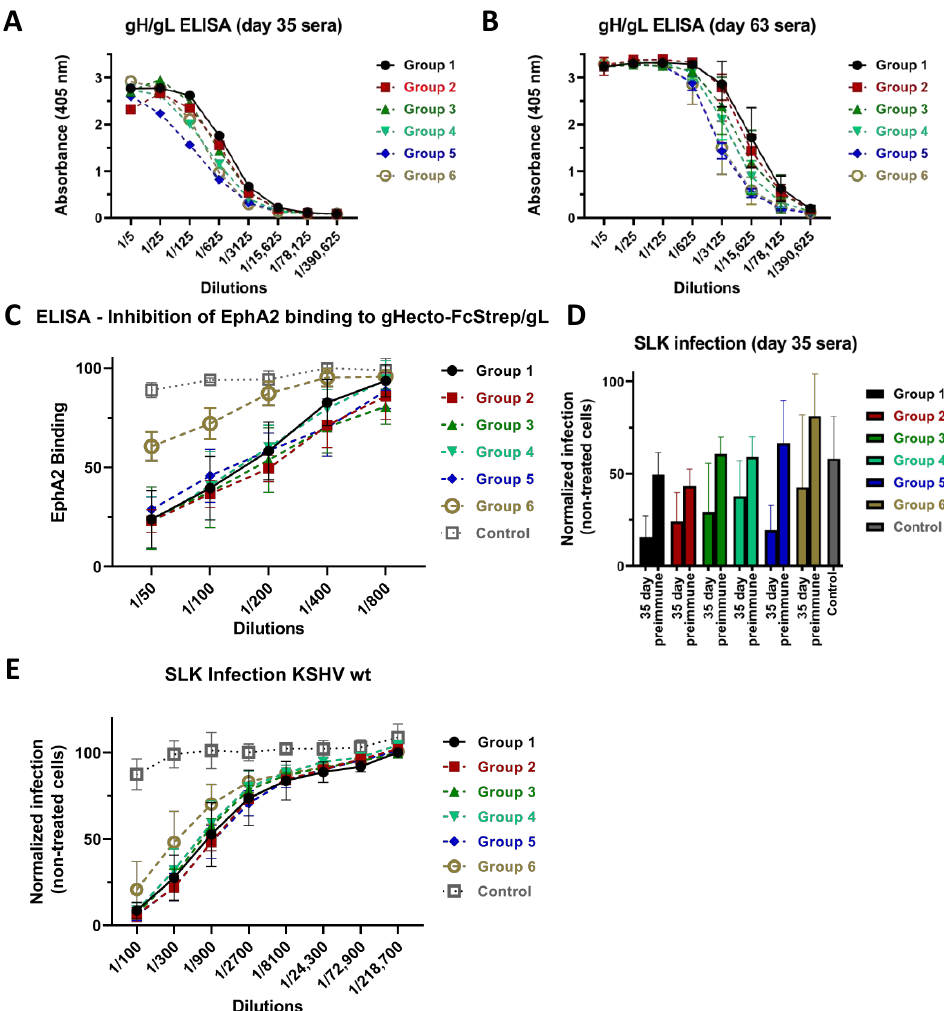
Figure 3. gH/gL binding, inhibition of EphA2 binding, and neutralization. ( A ) gHecto/gL-binding activity of pooled sera from each group at 35 days post start of the immunization schedule measured by ELISA. ( B ) gHecto/gL-binding activity averaged per group from individual sera at 63 days post start of the immunization schedule. Error bars indicate the standard deviation in each group. Group 3 ( p < 0.005), 4 ( p < 0.0001), 5 ( p < 0.0001) and 6 ( p < 0.0001) sera were significantly less reactive than Group 1 sera at 63 days (two-way ANOVA, Dunnet’s method for correction of multiple comparisons). ( C ) Sera raised against the different KSHV gHecto/gL complexes block gH/gL binding to immobilized EphA2 as measured by ELISA. Sera from Group 6 inhibited EphA2 binding significantly less potently than sera from Groups 1, 2, 3, 4, and 5 ( p < 0.0001; two- way ANOVA; Tukey’s method for correction for multiple comparisons). All sera inhibited binding significantly as compared to control ( p < 0.01, two- way ANOVA; Tukey’s m ethod for correction for multiple comparisons). The experiment was performed three times, values were normalized to binding without mouse serum, and normalized values were averaged for each serum. Values of the five sera of each group were then averaged and are shown. Error bars indicate the standard deviation in each group. ( D ) KSHV neutralizing activity of mice sera at 35 days. No significant difference between the groups was ob- served at 1/100 dilution by one-way ANOVA at day 35 (infection was normalized to infection with preimmune mouse sera; sera from individual mice were treated as biological replicates and aver- aged values of the five sera of each group are shown; error bars represent the standard deviation). ( E ) KSHV neutralizing activity of mice sera at 63 days. The Sera from Group 1 inhibited significantly more potently than Group 6 sera at 63 days ( p < 0.0001 extra sum-of-squares F test after non-linear fit for different IC50, inhibitor vs normalized response model; no correction for multiple compari- sons of Group 1 to the other groups). The experiment was performed three times; infection was normalized to infection without mouse serum and averaged for each serum. Sera from individual